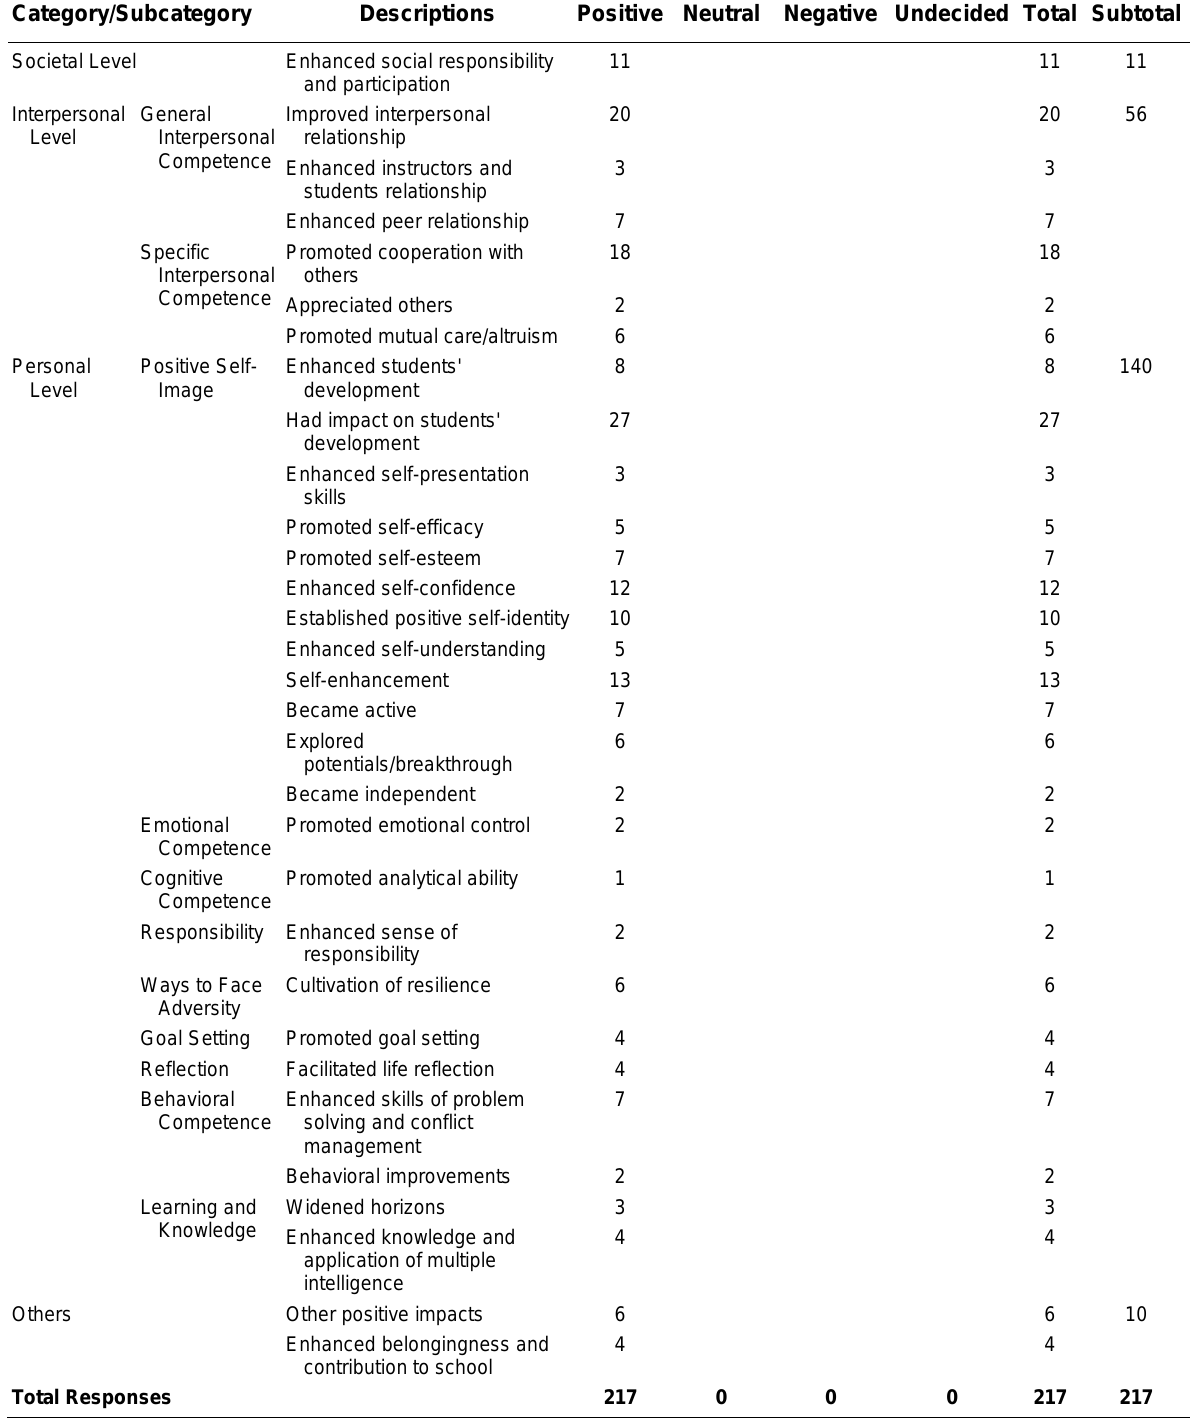
Responses on Perceived